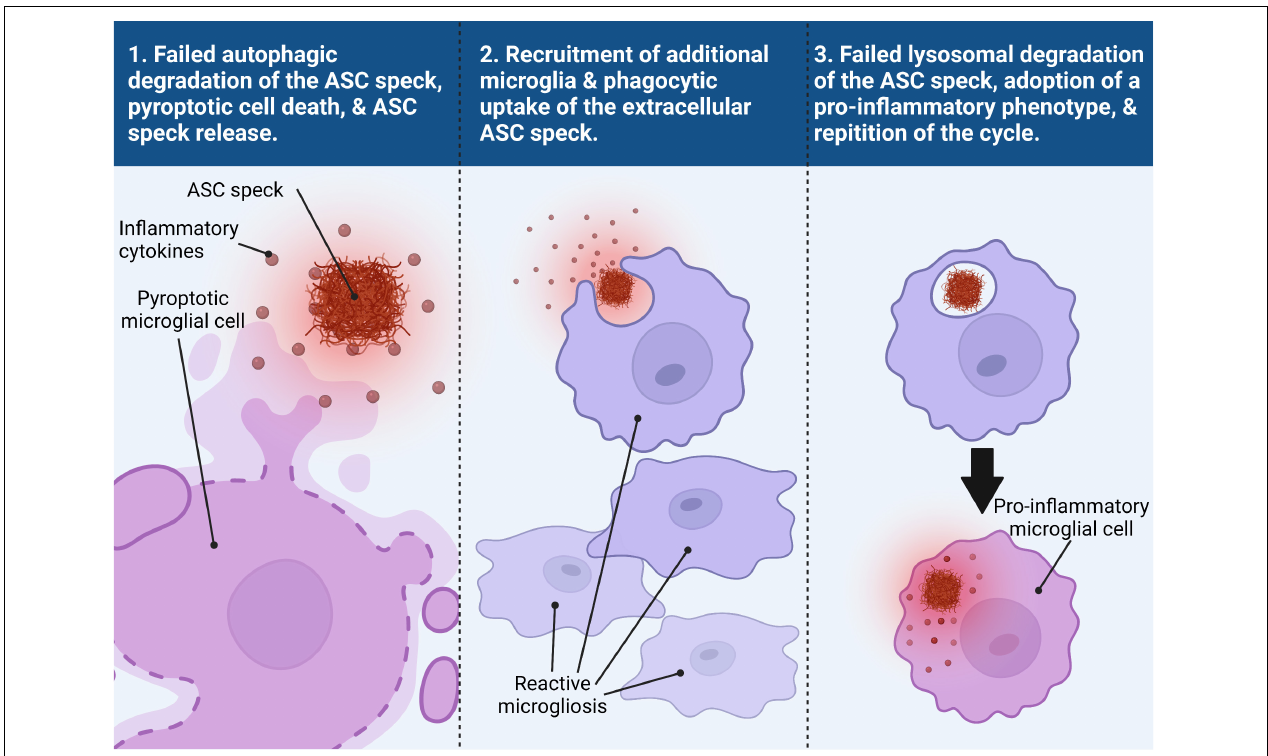
FIGURE 2 | Trans-microglial propagation of inflammation via ASC speck. Upon activation and assembly of the ASC speck from the NLRP3 inflammasome in response to misfolded protein aggregates, the microglial cell fails to degrade the ASC speck via autophagic clearance mechanisms (panel 1). Persistence of the ASC speck can result in either a non-pyroptotic exocytosis of the ASC speck or pyroptotic cell death, resulting in the release of inflammatory cytokines and the ASC speck into the extracellular space (panel 1). The extracellular ASC speck remains functionally active and the presence of inflammatory cytokines helps to recruit additional reactive microglia to the site of inflammation (panel 2). The ASC speck can then be taken up by another microglial cell where it can be degraded by the lysosomes (panel 3). Failed degradation of the ASC speck and possible lysosomal damage induces the microglial cell to adopt a pro-inflammatory phenotype (panel 3). This microglial cell can then undergo the same process as the previous microglial cell, perpetuating a viscous inflammatory